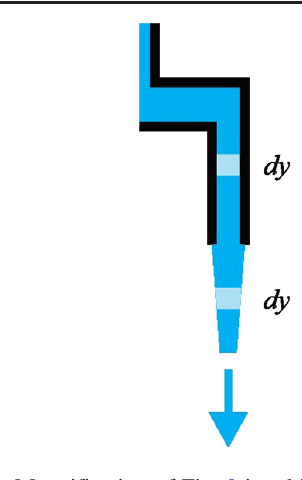
FIG. 10. Magnification of Fig. 9 in which two elements of the fluid with length dy were